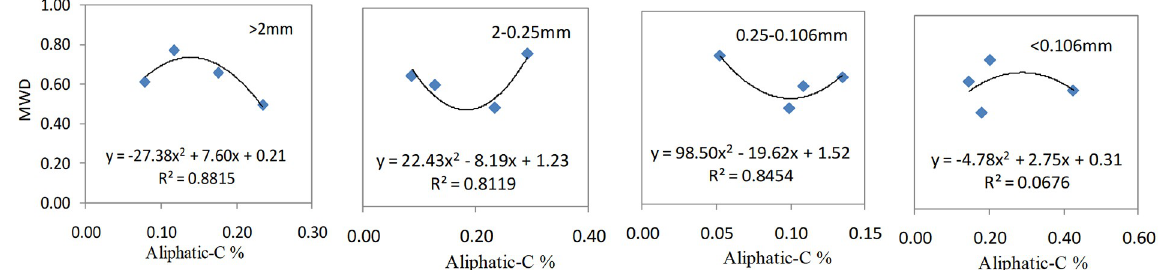
Fig 5. Regression models of aliphatic–C and soil aggregate stabilities for different particle sizes.